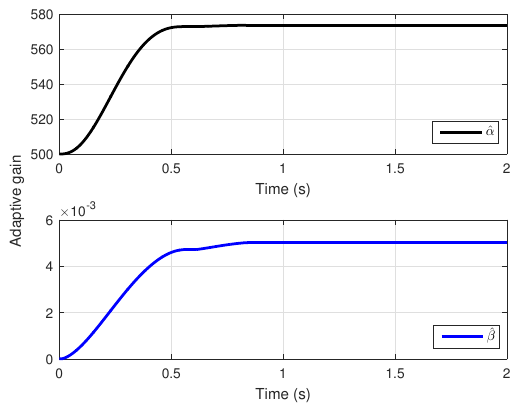
Figure 7. Adaptive gains of ISOSMC.